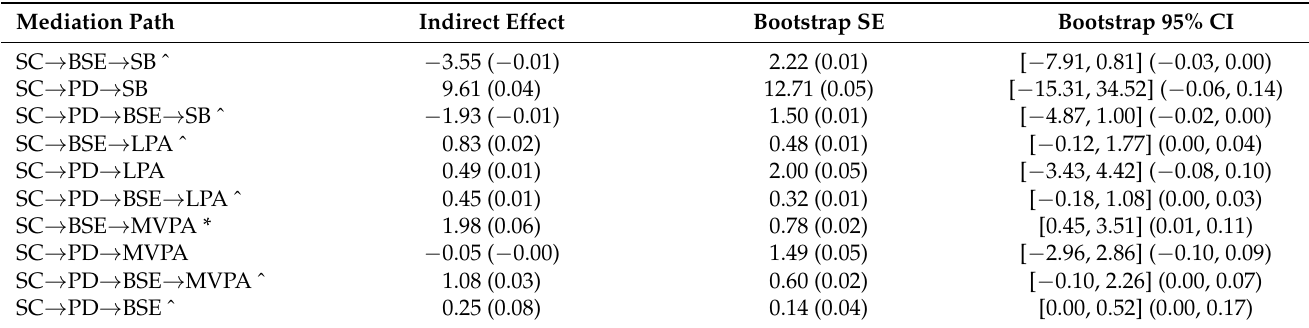
Table 3. Unstandardised and standardised indirect effect of hypothesised